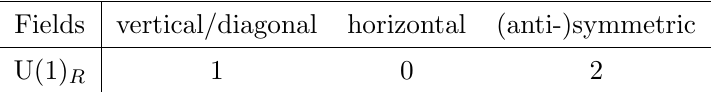
Table 1 . U(1) R -charge assignments for chiral super(cid:12)elds in the domain